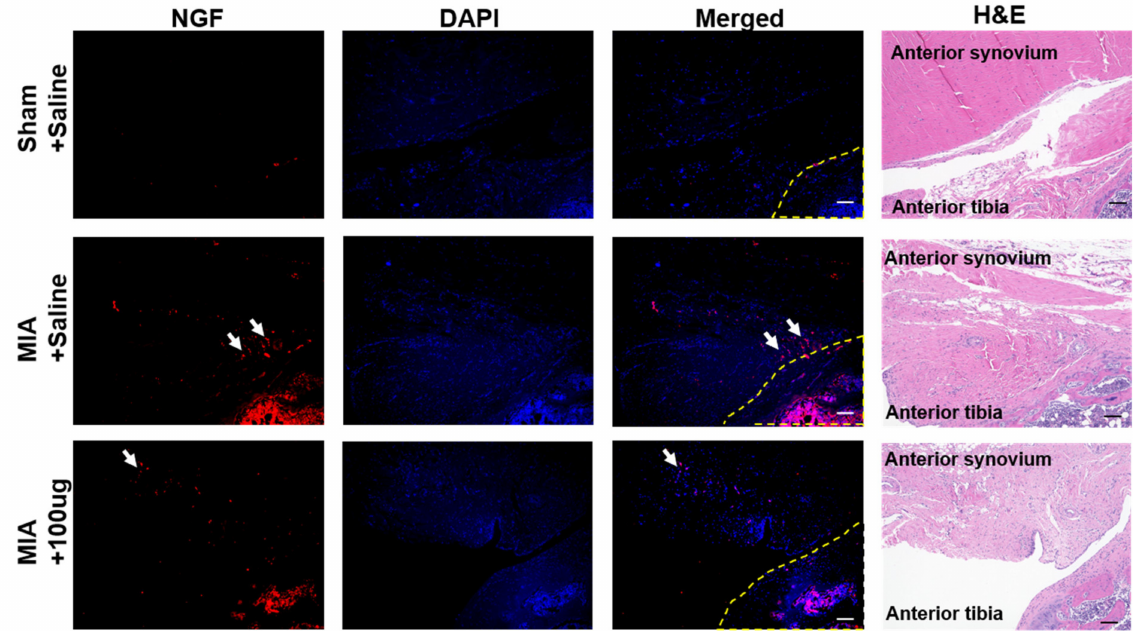
Figure 4. Fluorescent staining of knee joints indicates NGF concentration changes before and after treatment. MIA injection induced a NGF increase, which appears as a high NGF positive area. After the injection of 100 µ g NGF, there was a decrease of NGF positive reaction. Arrows indicate the positive reaction for the NGF. The yellow dotted line indicates the area of the articular cartilage and subchondral bone tissue. DAPI; 4 (cid:48) ,6-diamidino-2-phenylindole. The scale bar is 100 µ